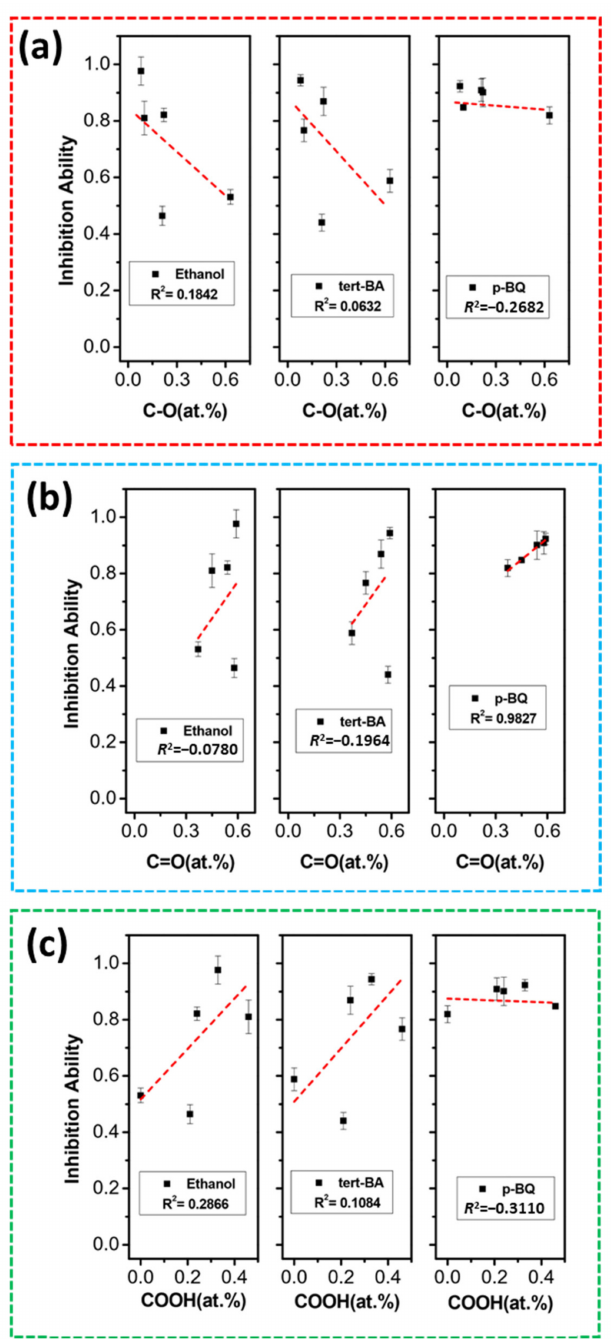
Figure 8. Role of radical (O 2 • − -, • OH and SO 4 • − ) quenchers on ACP degradation rate ( k 1 ). Correla- tion between k 1 -C-O ( a ), k 1 and -C=O ( b ) and k 1 and -COOH ( c ). Quenching studies were carried out at C ACP = 10 mg L − 1 , C Catalyst = 100 mg L − 1 , C PMS = 0.5 mM, C Ethanol or C tert-BA = 500 mM, C p-BQ = 50